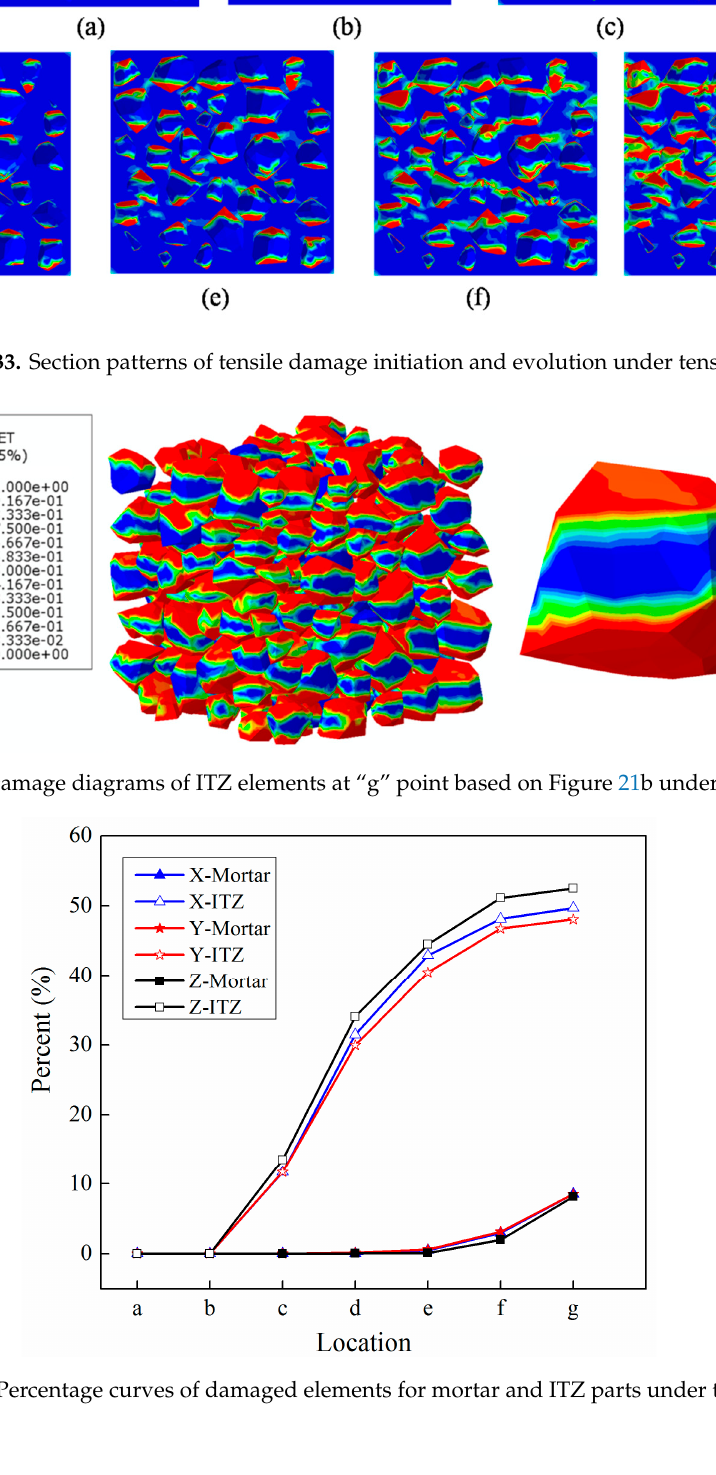
Figure 35. Percentage curves of damaged elements for mortar and ITZ parts under tension.